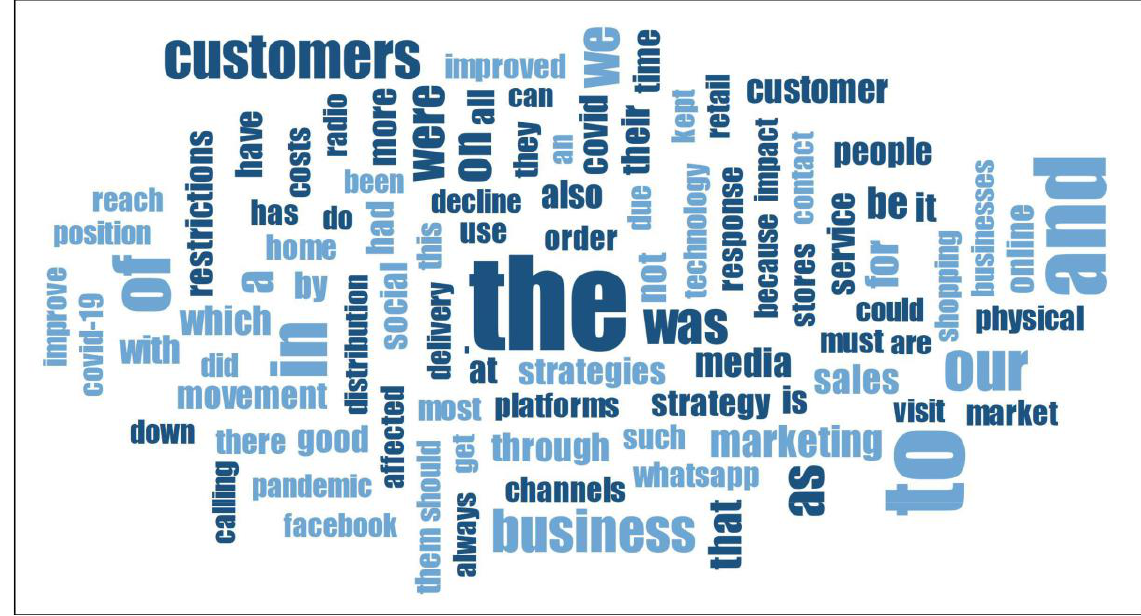
Figure 6: Word Cloud Research Participants Responses; Source: Authors (2023) – Extracted from MAXQDA